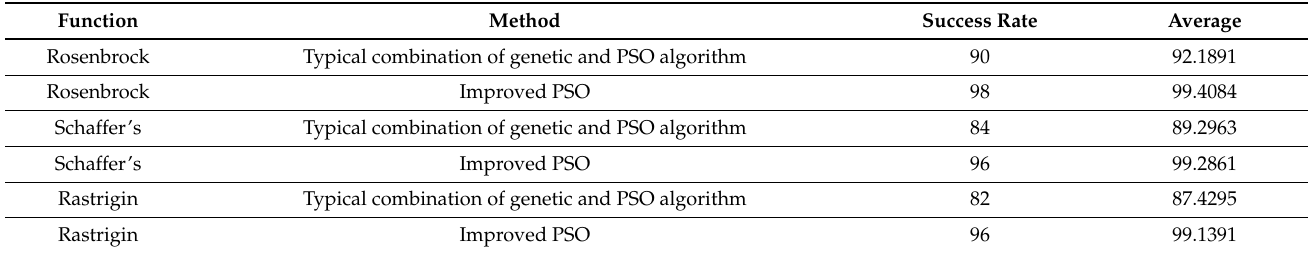
Table 4. Comparisons of our improved PSO algorithm with a typical combination of genetic and PSO